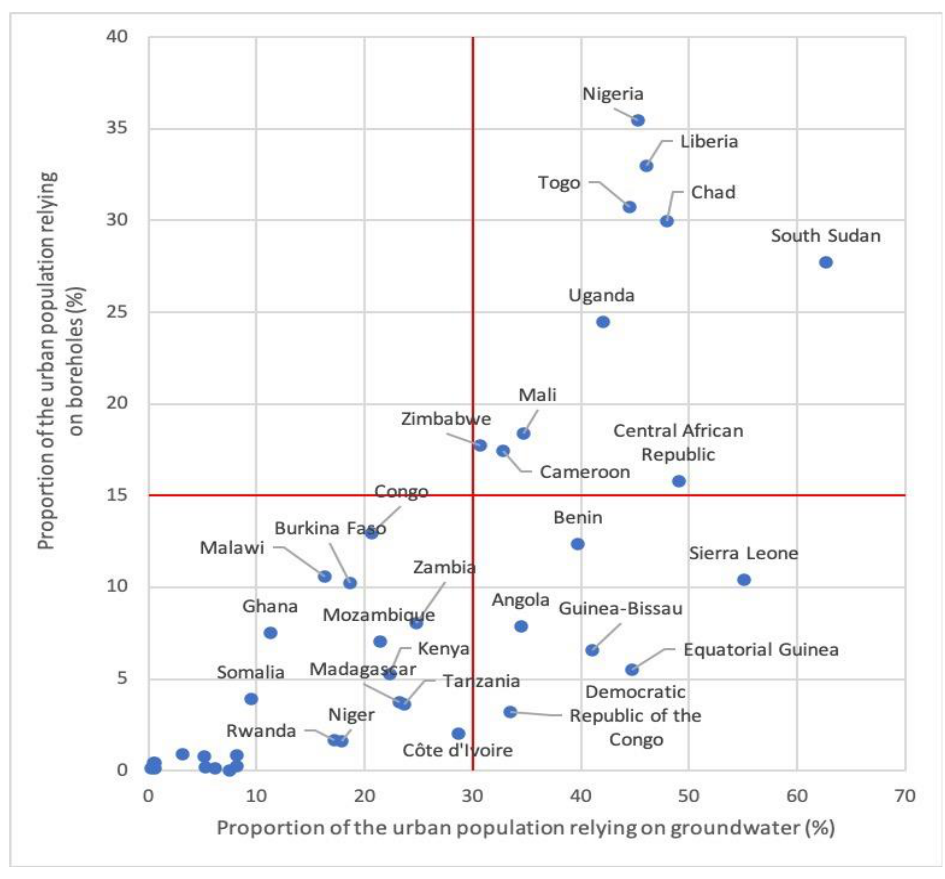
Figure 4. Relationship between groundwater point source use and boreholes. Source: adapted from [1].